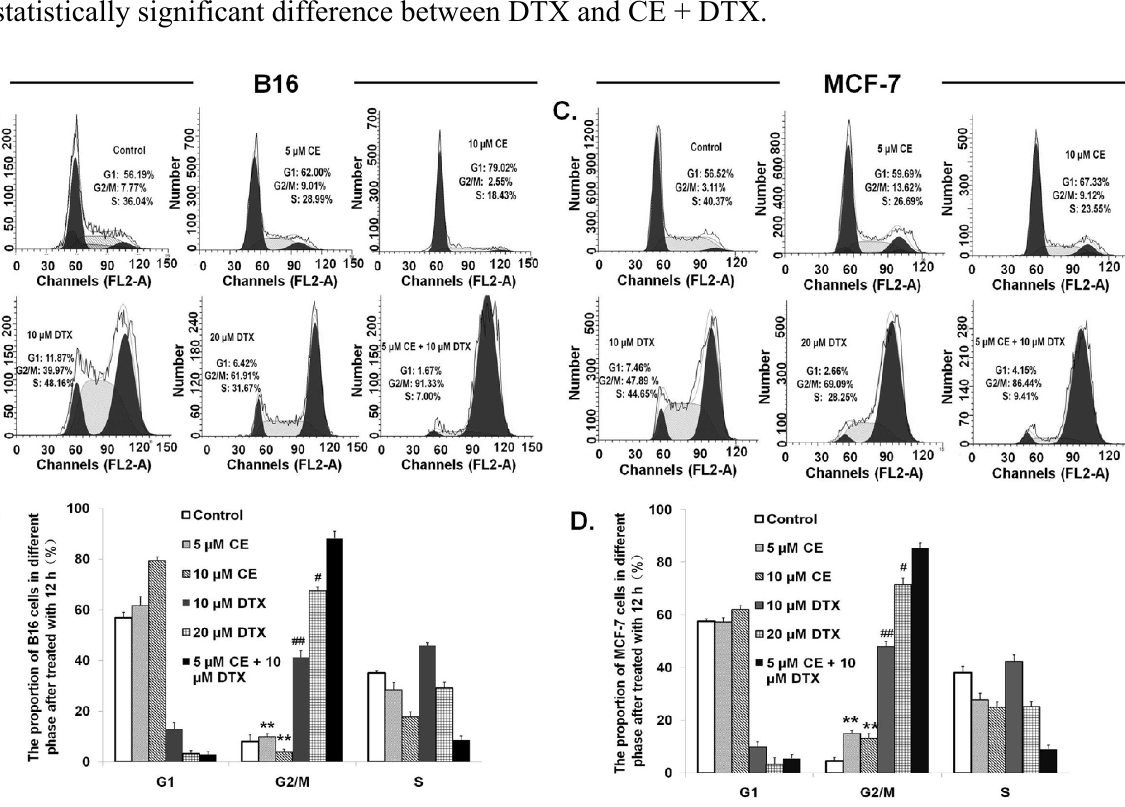
Figure 5. Cell cycle effect of CE + DTX on B16 and MCF-7 cells ( n = 3). Cells were treated with either CE (5 or 10 μ M) or DTX (10 or 20 μ M), or combination (5 μ M CE plus 10 μ M DTX) for 12 h incubation, while 0.3% DMSO-PBS served as control. ( A , C ) Representative experiments on B16 and MCF-7 cells, respectively; ( B , D ) Data summary and analysis of the proportion of B16 cells and MCF-7 cells in different phase after treatment according to the results of flow cytometric analysis. ** p < 0.01, statistically significant difference between CE and CE + DTX; # p < 0.05, ## p < 0.01, statistically significant difference between DTX and CE +